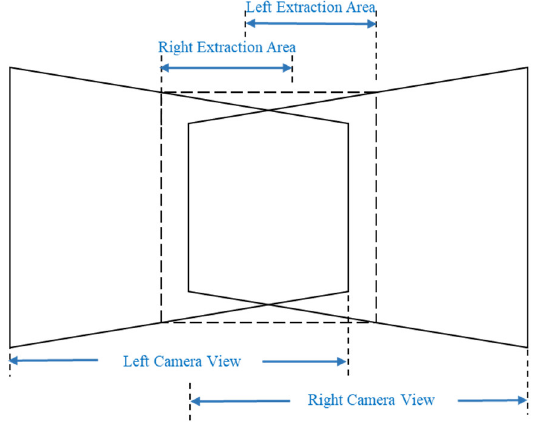
Figure 2. Schematic diagram of the improved feature point extraction area.